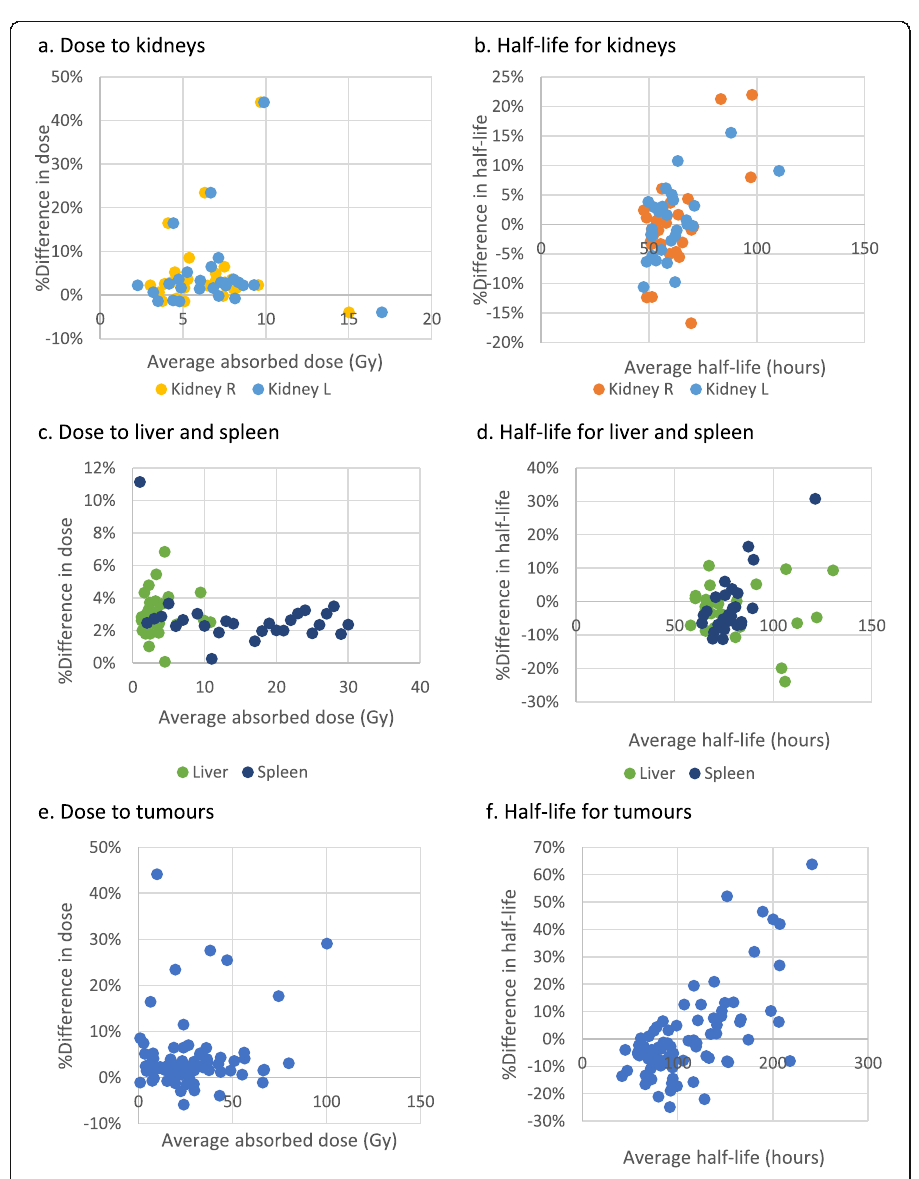
Fig. 4 Bland-Altman plots showing % difference between 4-point mono-exponential fit and “ original method ” (combined trapezoidal/3-point-mono-exponential fit) for absorbed dose ( a ) and effective half-life ( b ) in the kidneys, liver and spleen ( c and d ), and tumors ( e and f ), plotted against average absorbed dose (Gy) and effective half-life (hours) for the two